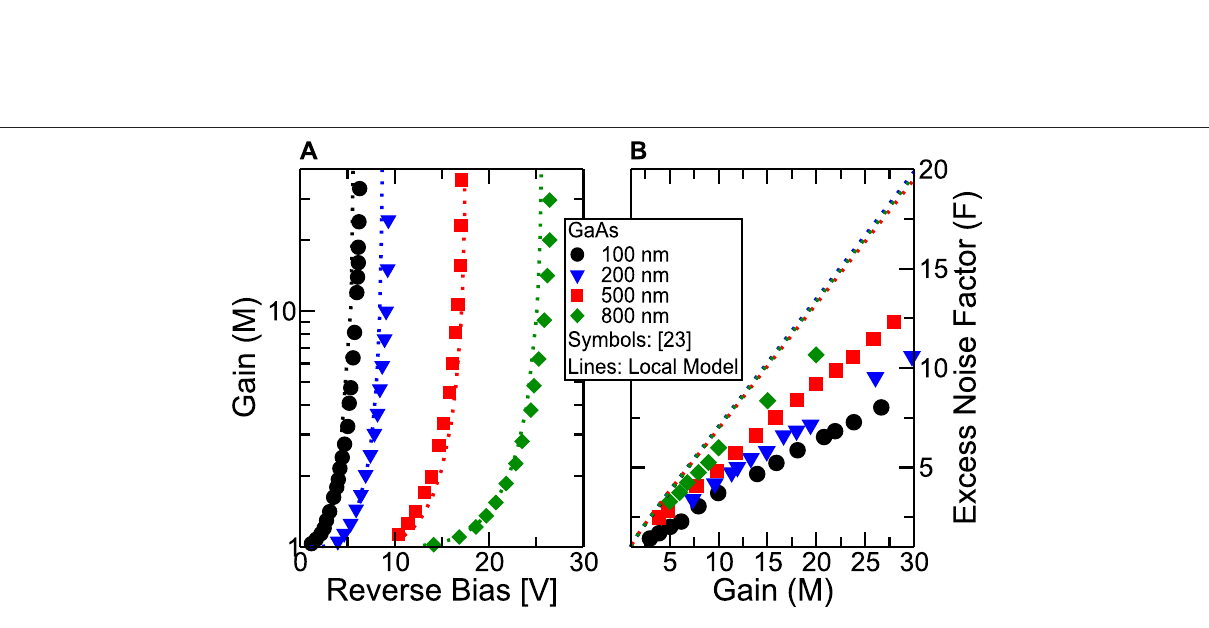
FIGURE 4 | (A) Ratio between the hole and electron impact ionization coef fi cients for Si from [42] (black solid) and for GaAs from [43] (red dashed) at room temperature. (B) Attenuation length in Si (black solid) and in GaAs (red dashed) for photon energies in the range 30 ≤ E ph ≤ 15,000 eV from [44].